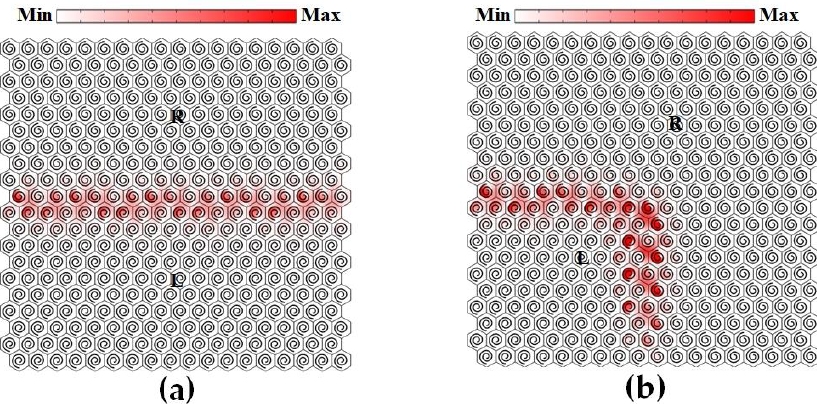
Figure 9. Transmitted edge states through different waveguide configuration ( a ) straight waveguide and ( b ) zigzag waveguide at 3130 Hz.